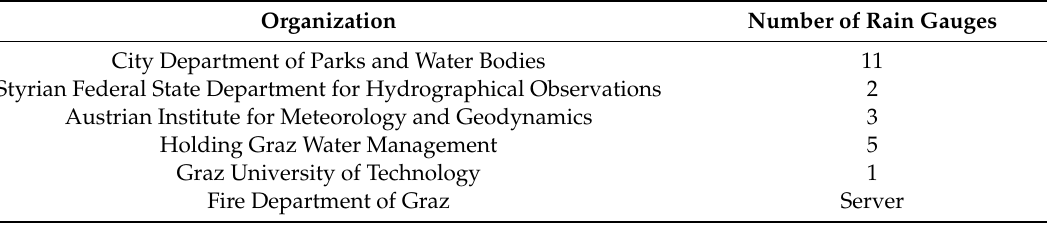
Figure 1. Locations of the rain gauges of the Graz City Measurement Network differentiated in rain gauges analyzed and not analyzed in this paper (owners listed in Table 2). The city’s location within Central Europe is indicated in the grey map. Table 2. Assembly of the Graz City Measurement Network (GCMN).